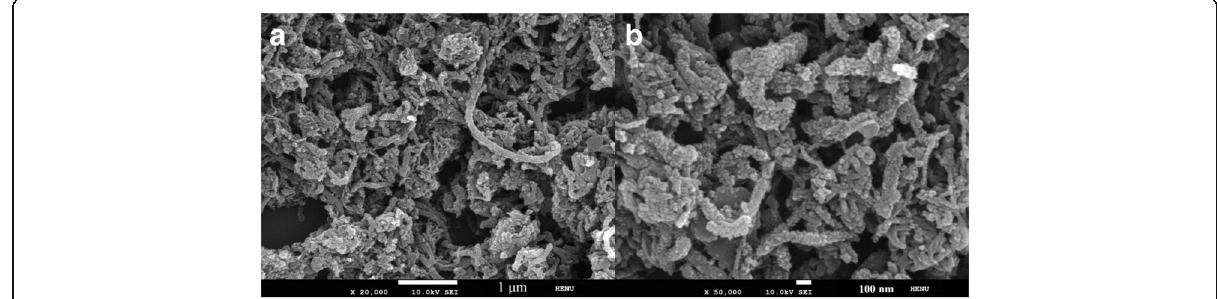
Fig. 4 The SEM images of the PANI|MWCNTs ( a , b